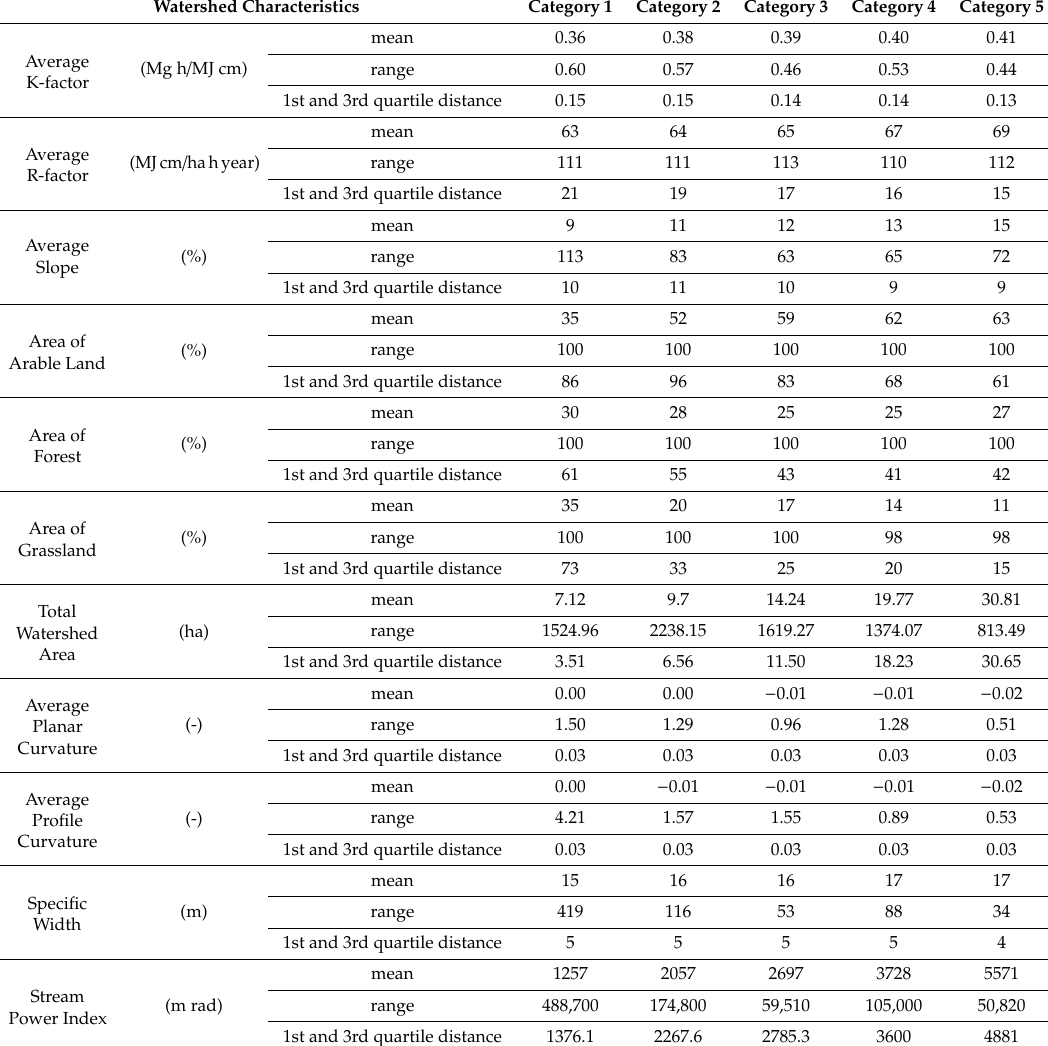
Table 3. Average values of the analyzed characteristics in risk watersheds representing the five threat